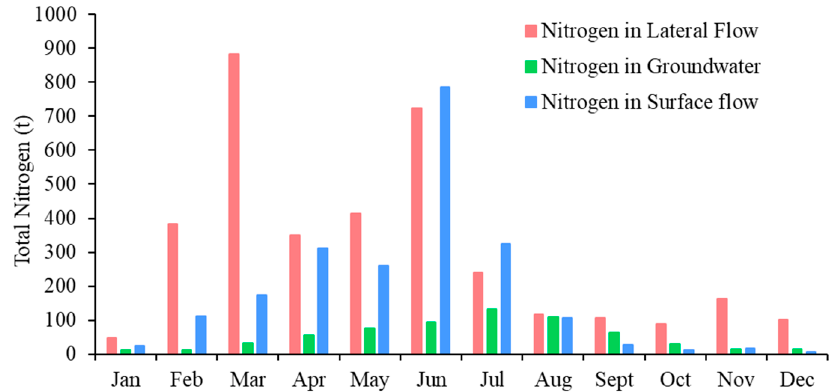
Figure 9. Monthly dynamics of TN movement via three different non-point source routes.